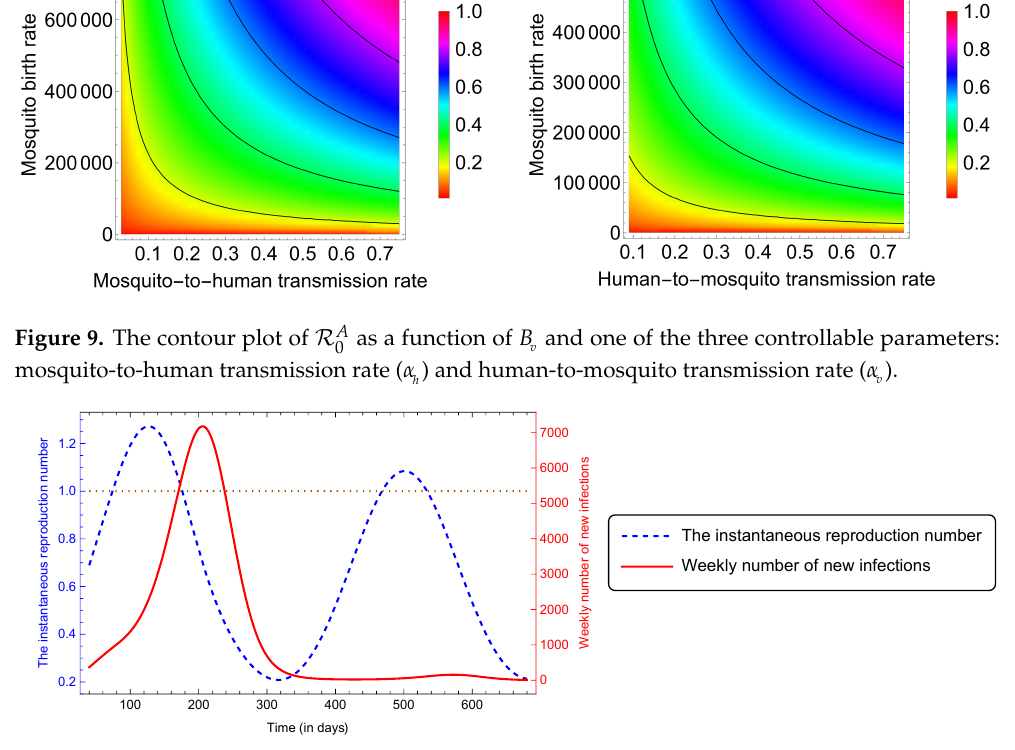
Figure 10. The instantaneous reproduction number and the number of symptomatically infected in Colombia,